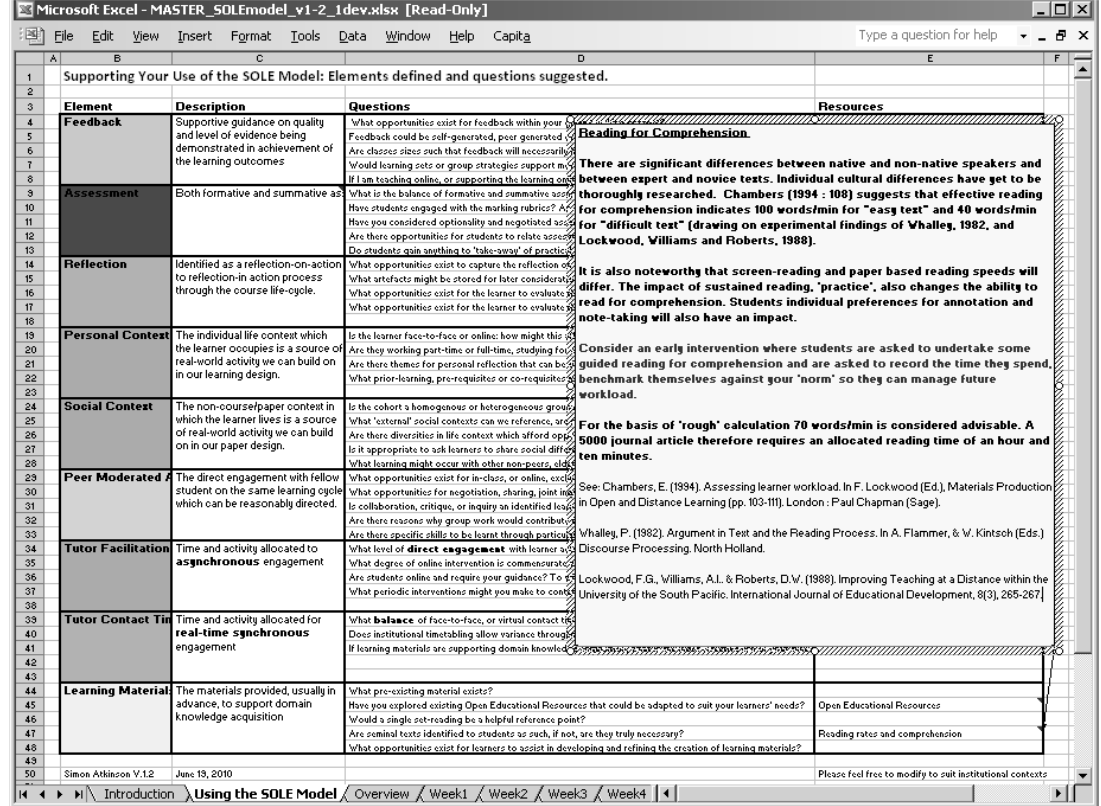
Figure 4 . Version 1.2 with pedagogical guidance associated with each of the nine elements of the SOLE